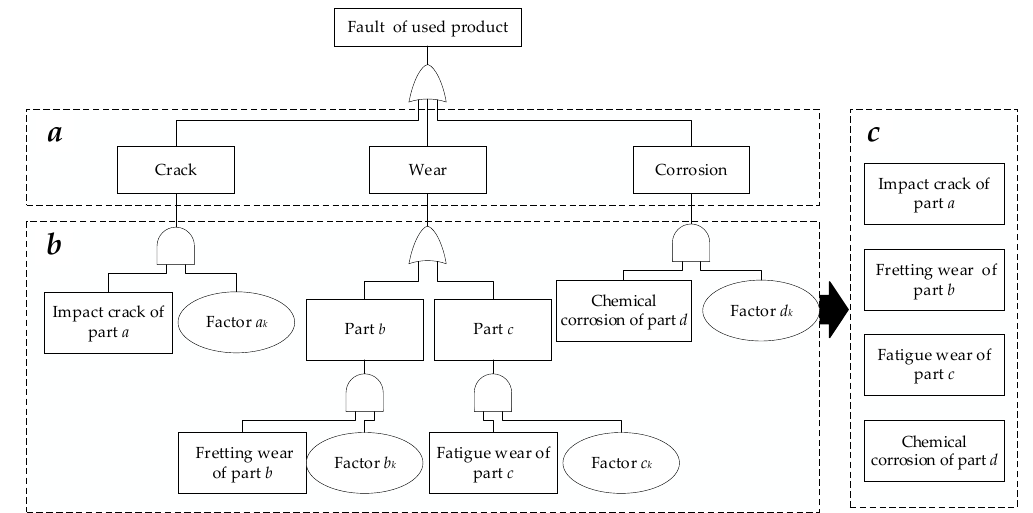
Figure 2. Fault feature extract of failure surface by FTA. In Figure 2, “ ”in ( a ) is the input events, representing the main failure perfor- mance of the used parts of this type of used product; “ ” and“ ”in ( b ) is the input events and condition events, representing the specific failure type of used parts and the cause of the failure type, respectively; “ ” in ( c ) is the output events, representing the specific failure parts and failure types of the used product; “ ”and” ”are AND gate events and OR gate events, respectively.